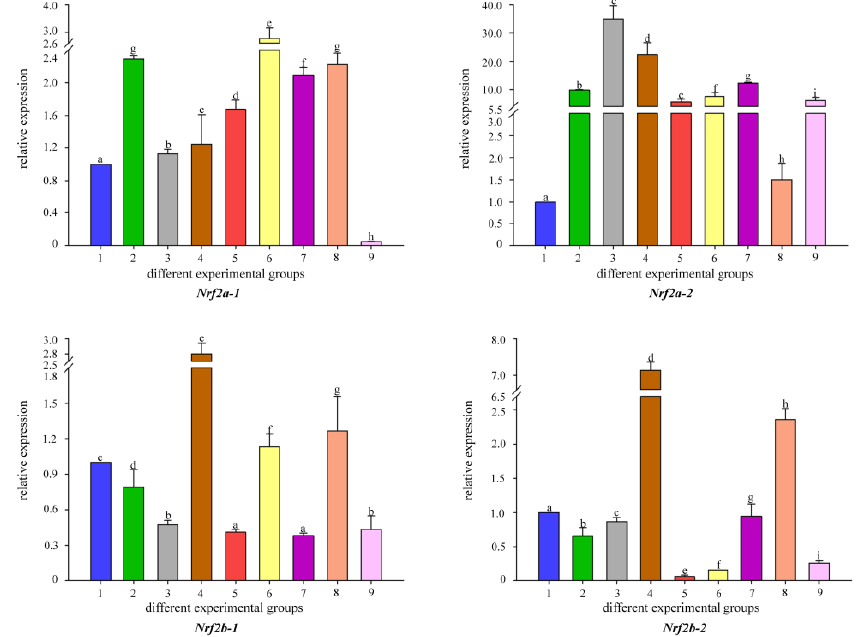
Figure 6. Temporal expression of Nrf2 mRNA relative to control and normalized by qRT-PCR for changes in β -actin in the gut of common carp, challenged for 30 and 60 days. Significant differences between the challenge, infection, and control groups are indicated by letters, p < 0.05: 1 is the blank control group; 2 is the heavy metal Cd 2+ -stress group at 30 days; 35 is the B. coagulans group with L1, L2, and L3 concentrations in the feed at 30 days; 6 is the heavy metal Cd 2+ -stress group at 60 days; 79 is the B. coagulans group with L1, L2, and L3 concentrations in the feed at 60 days group. Figure 7. Temporal expression of Nrf 3 mRNA relative to control and normalized by qRT-PCR for changes in β -actin in the gut of common carp, challenged for 30 and 60 days. Significant differences between the challenge, infection, and control groups are indicated by letters, p < 0.05: 1 is the blank control group; 2 is the heavy metal Cd 2+ -stress group at 30 days; 35 is the B. coagulans group with L1, L2, and L3 concentrations in the feed at 30 days; 6 is the heavy metal Cd 2+ -stress group at 60 days; 79 is the B. coagulans group with L1, L2, and L3 concentrations in the feed at 60 days group.